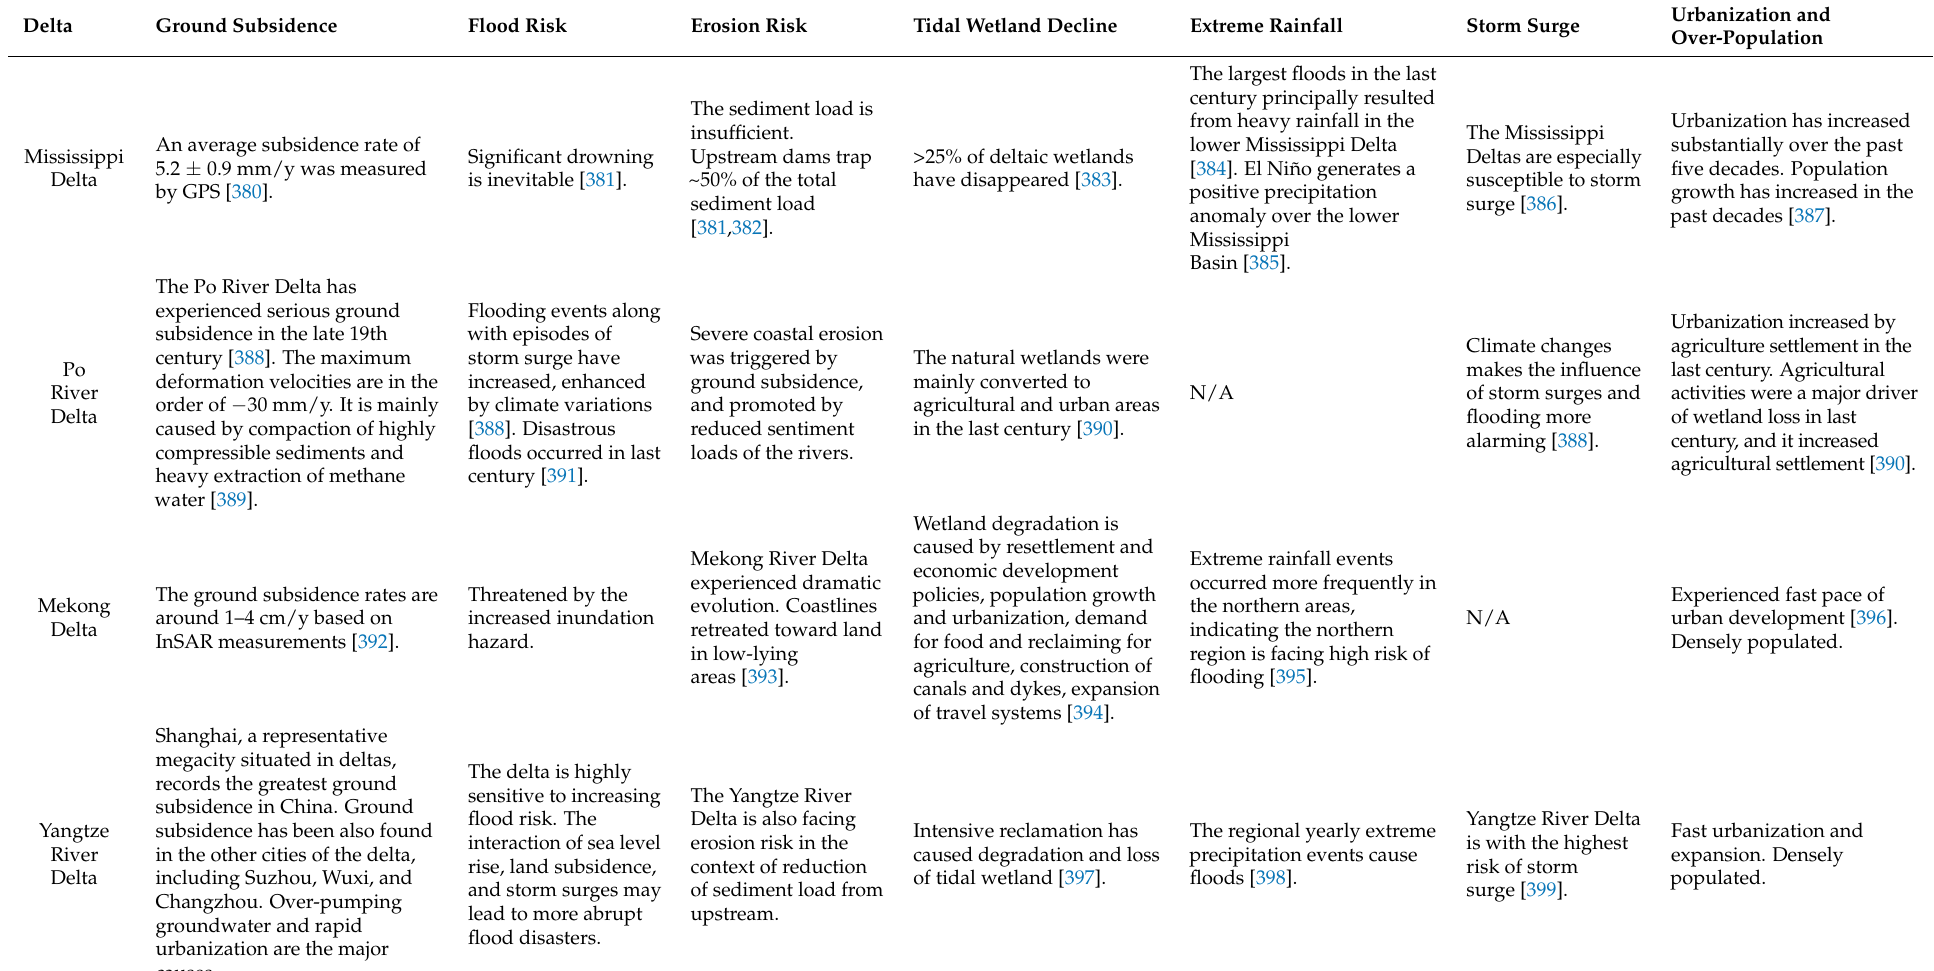
Table 2. Significant risks for eight critical deltas (refer to